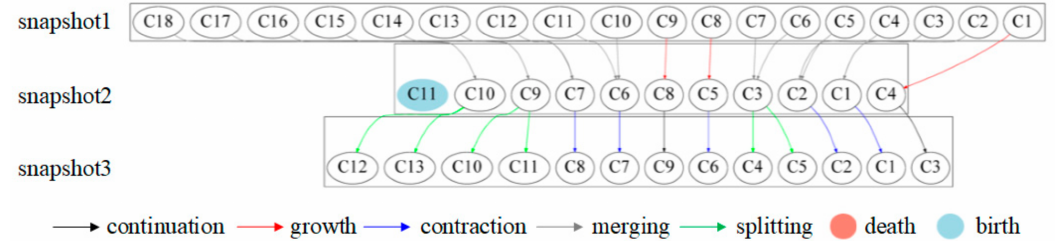
Figure 8. The evolution of the communities identified by EACO in the simulated dataset.